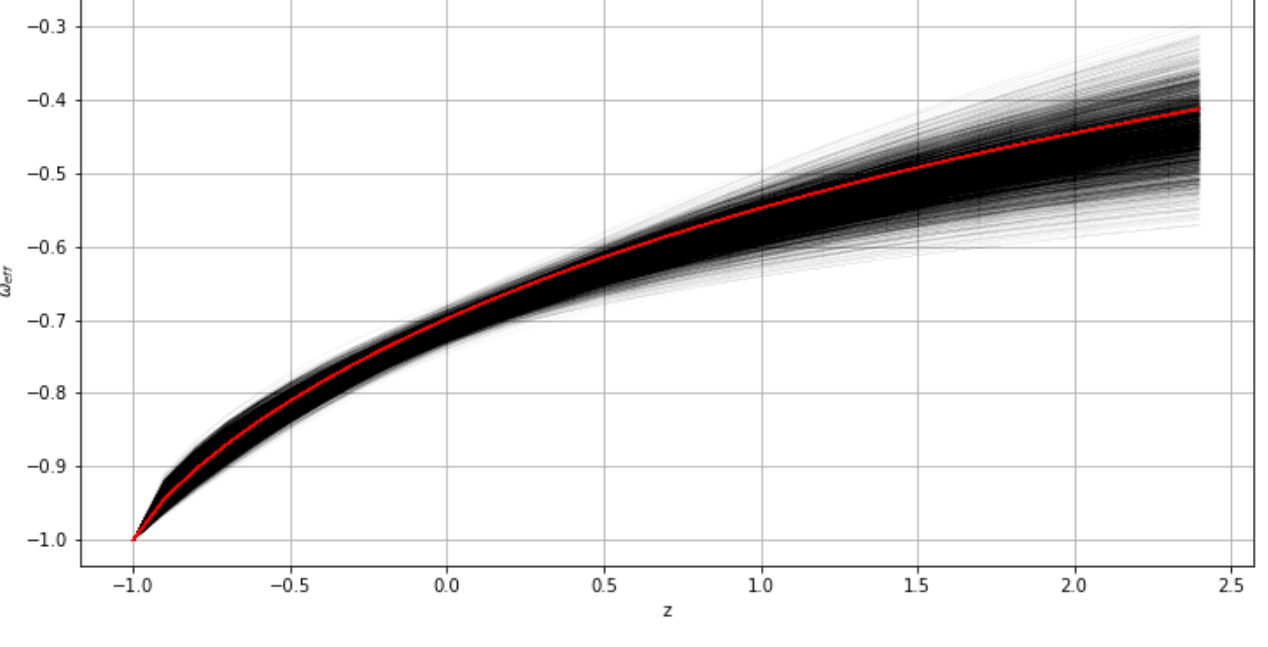
Figure 4. The reconstruction of the effective EoS parameter as a function of the redshift, for our model, is presented for 7500 samples, which are reproduced by re-sampling the chains through emcee . We plot all the obtained curves, alongside the curve corresponding to the best fit of the parameters (red